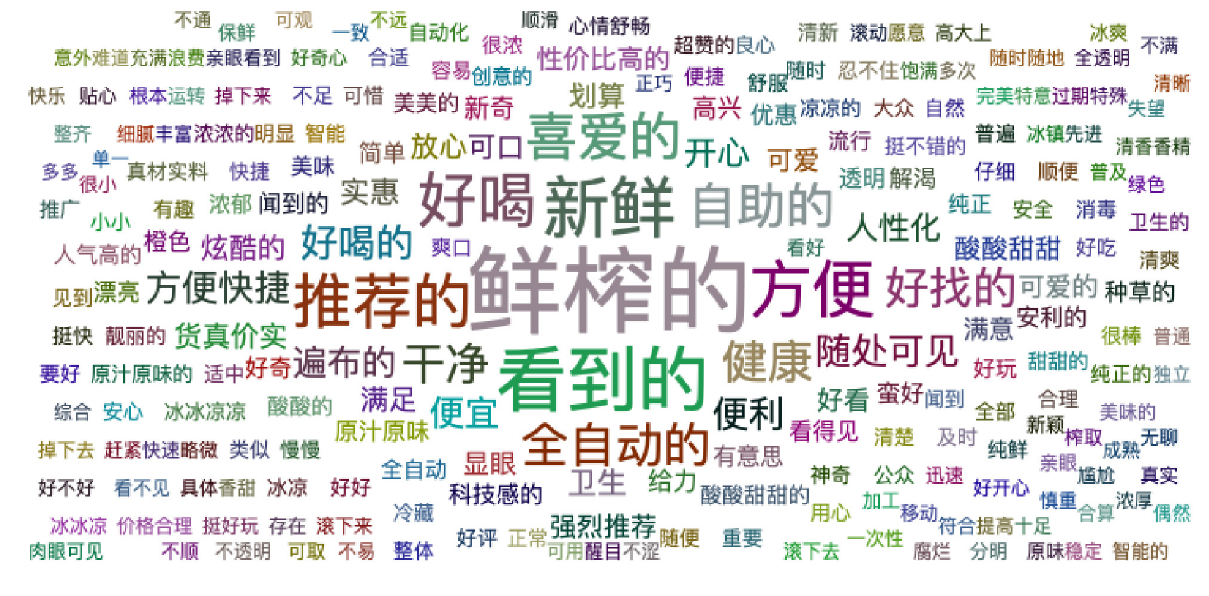
FIGURE 4 | Adjective cloud figure of “Angel Orange” unmanned retail terminal.